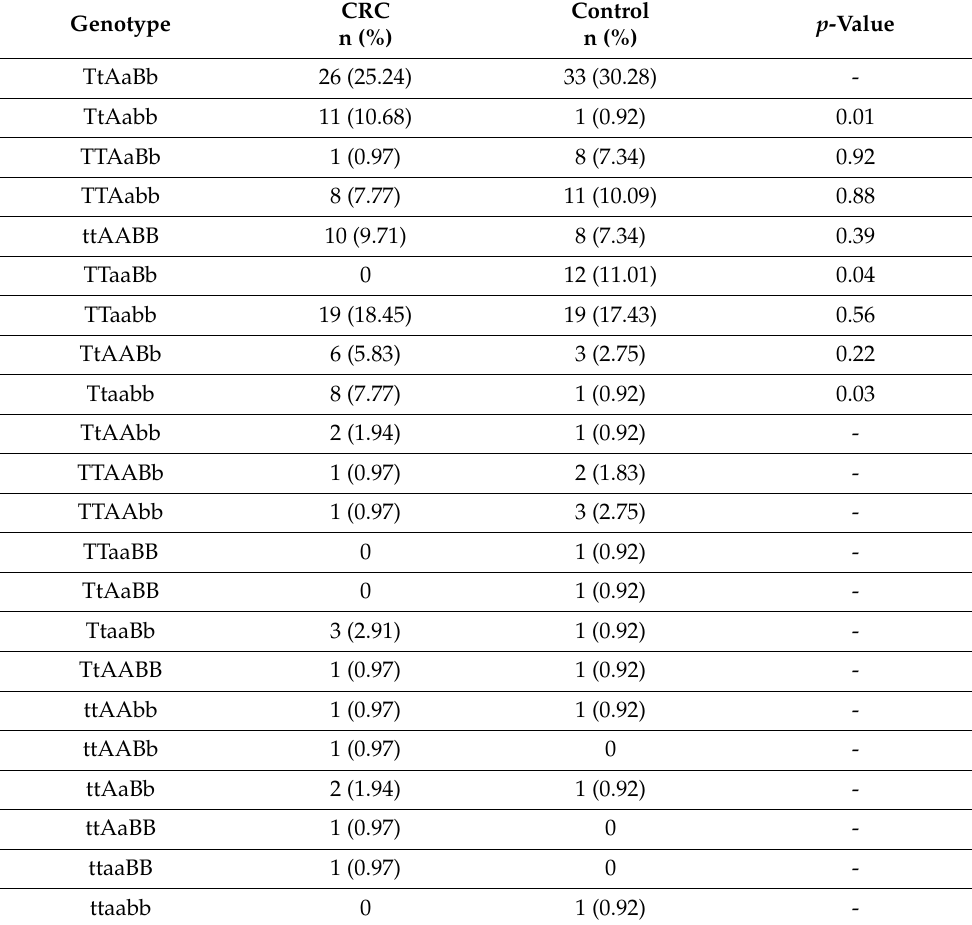
Table 7. Combined genotypes and their percentage among investigated